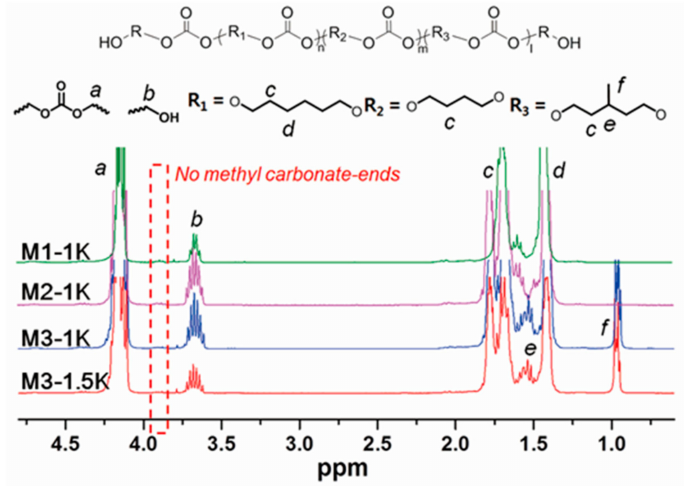
Figure 2. 1 H NMR spectra of carbonate-type macrodiols in CDCl 3 (300